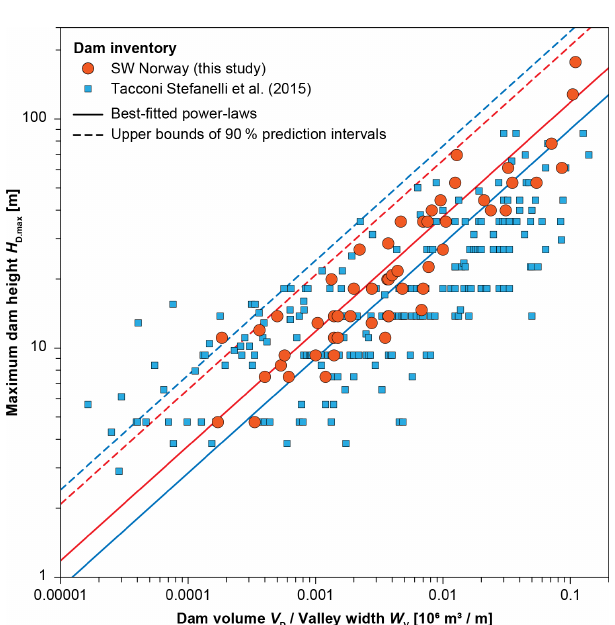
Figure 6. Relationship between maximum dam height H D . max and the ratio between dam volume V D (in 10 6 m 3 ) and valley width W V (in metres) for RSF dams in southwestern Norway (data from Jakobsen, 2015), compared to the dataset from Tacconi Stefanelli et al. (2015). H D . max increases with V D /W V according to power- law distributions as in Eq. (3) with scale factors as in Table 2 (with colours matching the point symbols).